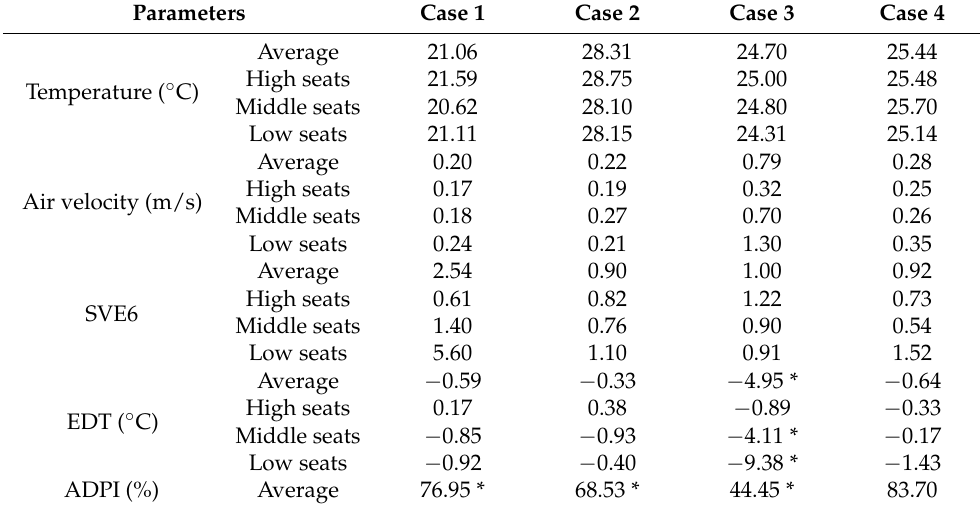
Table 6. Simulation results of each case.